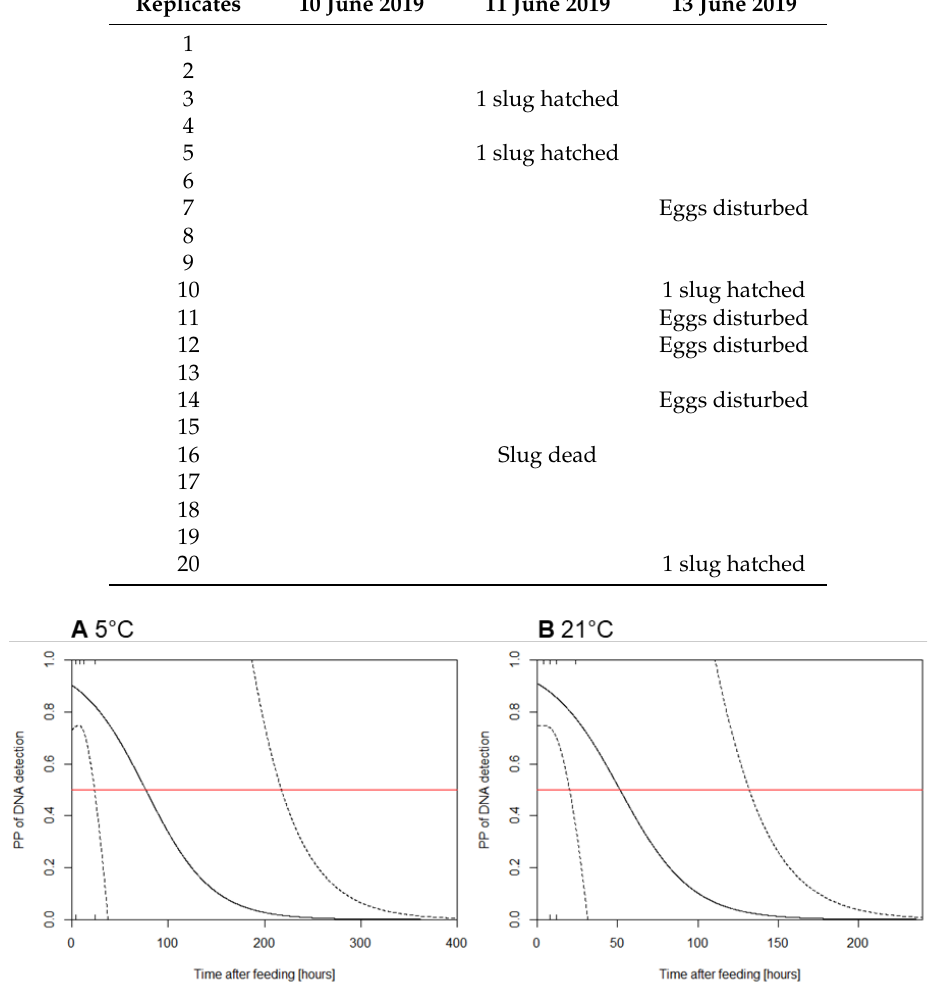
Figure A1. Predicted probability (PP, solid line ) and 95% confidence intervals ( broken lines ) of slug DNA detection in the guts from Nebria brevicollis killed at different time intervals and kept at either 5 ◦ C ( A ) or 21 ◦ C ( B ) after feeding on Deroceras reticulatum cadavers. The red line indicates the point on the y axis where probability of DNA detection is 0.5. The small vertical lines at the top and bottom of the left side of each graph are the data from our study, indicating positive (located at y = 1.0) and negative (located at y = 0.0) qPCR results at each tested time slot (0, 4, 8, 12 and 24 h).